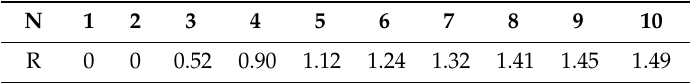
Table 3. Random index value corresponding to the norm.